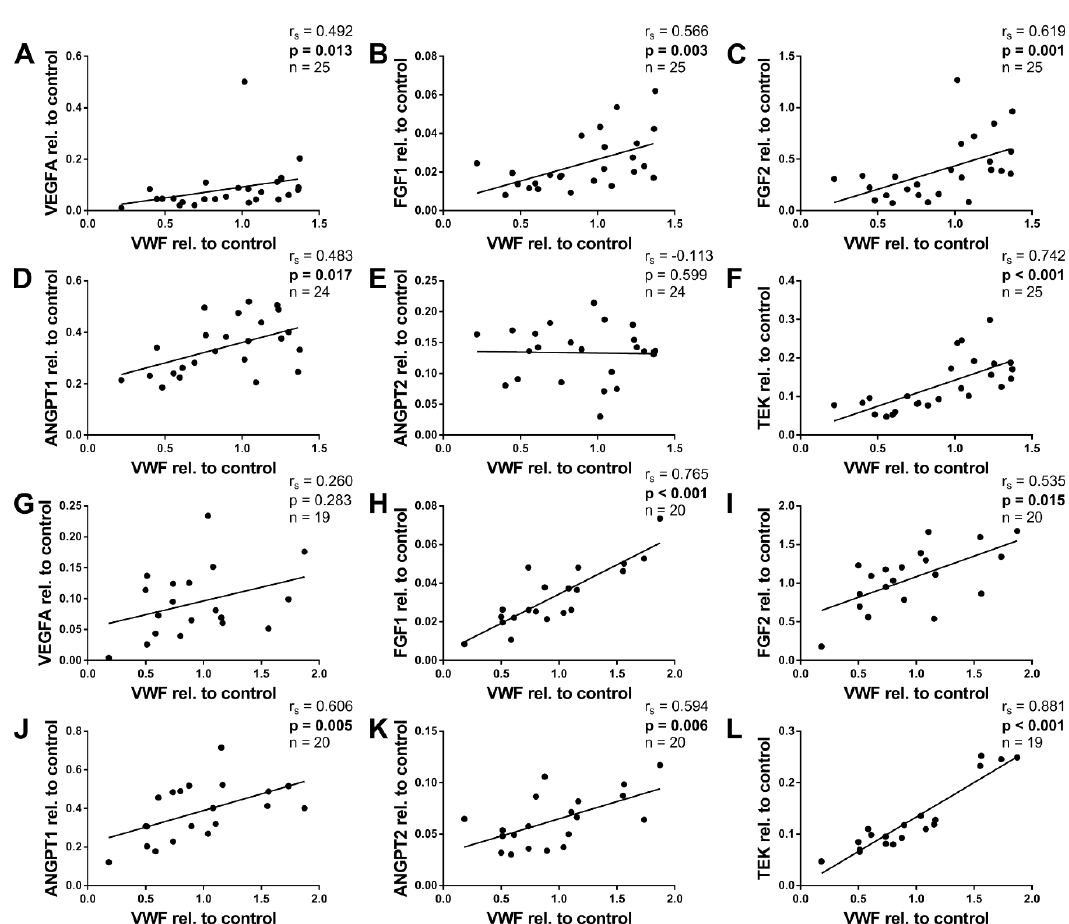
Figure A5. Association of VWF with angiogenic gene expression in the WAT of infants <6 and children ≥6 months. Total RNA was isolated, reverse transcribed, and subjected to qPCR analysis using specific primer pairs as indicated. Respective gene expression was calculated as described in Methods. ( A – F ) Like in the analysis with all children, all analyzed angiogenic factors, with the exception of ANGT2, correlated positively with VWF when performing the analysis with the infants <6 months only. ( G – L ) In the children ≥6 months VEGFA did not correlate significantly with VWF (G). In contrast to the analyses with the infants <6 months and all children, ANGPT2 correlated positively with VWF in the ≥6 months group (K). (H–J, L) As in the infants <6 months FGF1, FGF2, ANGPT1, and L also correlated positively with VWF in the children ≥6 months. Spearman correlation coefficient r s and p value, as well as number of subjects, are given in each scatter plot. Significant p values ( p < 0.05) are indicated in bold. Trend lines were calculated as linear regressions.